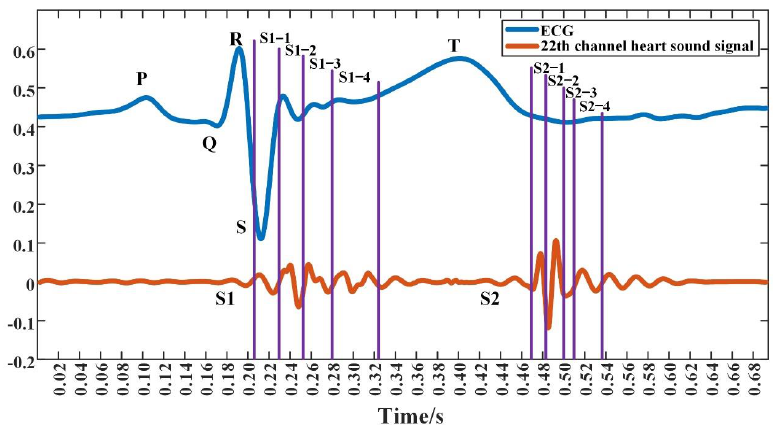
Figure 11. ECG signal and heart sound signal acquired on channel 22 on a male aged 27, 183 cm in height and 65 kg in weight. The first heart sound (S1) and the second heart sound (S2) are each divided into four stages.